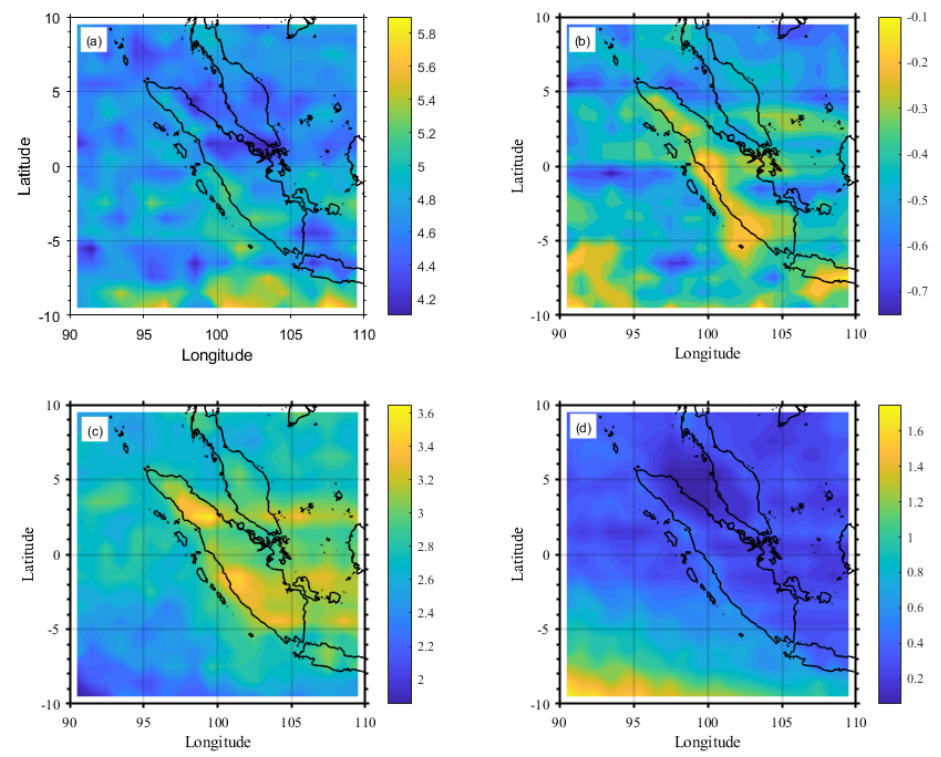
Figure 2. Spatial distribution of vertical profile of reflectivity gradient (VPRG) for stratiform rain at the altitude of 5 - 7 km